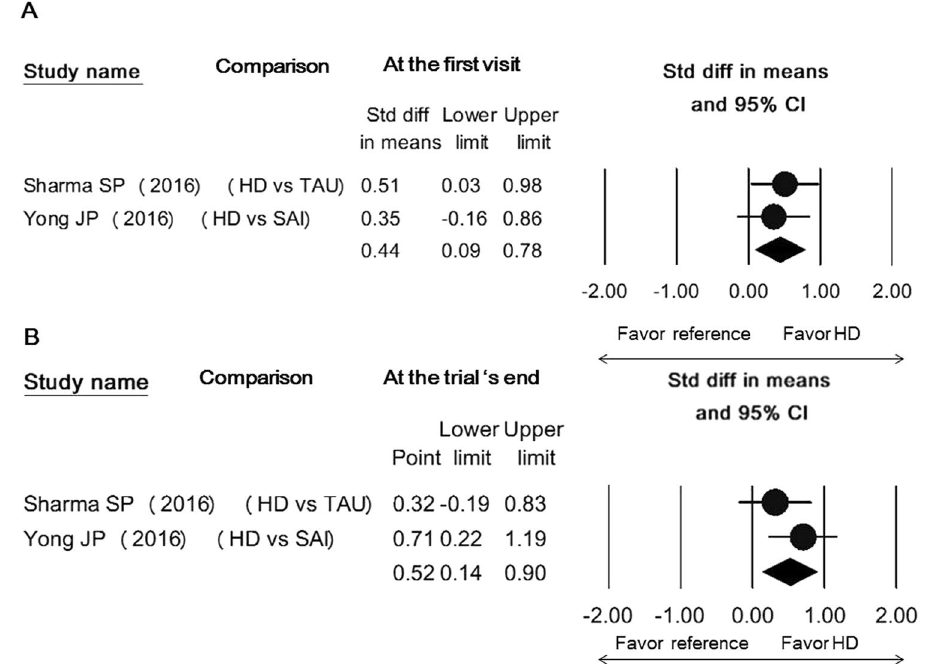
Figure 6. Forest plot of standardized mean differences of improvement in internal rotation with the use of hydrodilatation and/or various reference treatments early following intervention ( A ) and at the trial's end ( B ). Abbreviation: hydrodilatation, HD; TAU, treatment as usual; SAI, subacromial